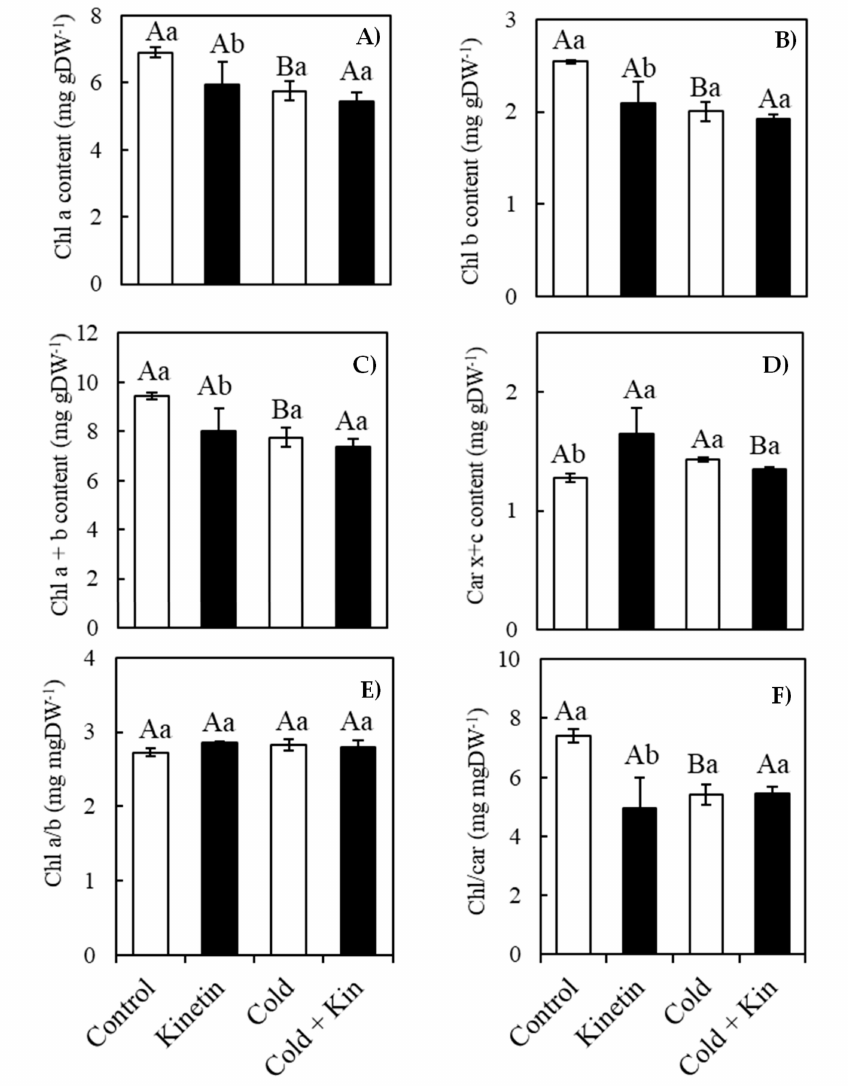
Figure 2. The e ff ect of exogenous kinetin on the contents of chlorophyll a ( A ), chlorophyll b ( B ), total chlorophylls ( C ), total carotenoids ( D ) as well as the ratios of chlorophyll a / b ( E ) and total chlorophyll / total carotenoid ( F ). Kin, kinetin. Di ff erent capital letters, (A, B) denote statistically significant di ff erences between the parameter means within temperature treatments, whereas di ff erent small letters, (a, b) denote statistically significant di ff erences for the parameter means within kinetin treatments ( p < 0.05, Newman Keuls’ test). Means are a replicate of three independent samples ( n = 3). Error bars represent the standard deviation of the